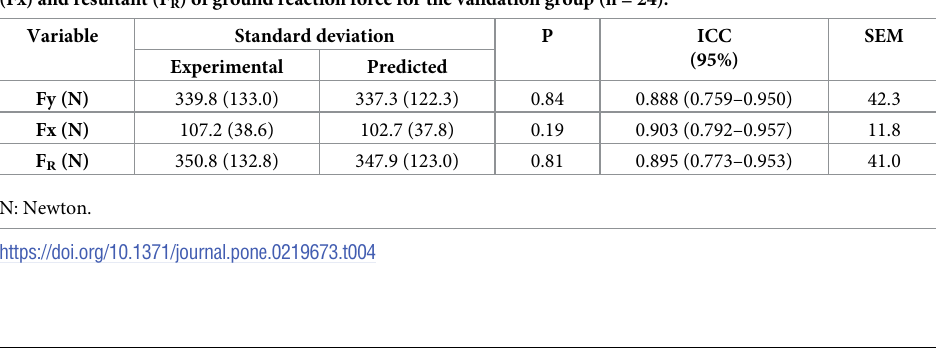
Table 4. Comparison between the predicted and experimentally measured values of vertical (Fy), antero-posterior (Fx) and resultant (F R ) of ground reaction force for the validation group (n =